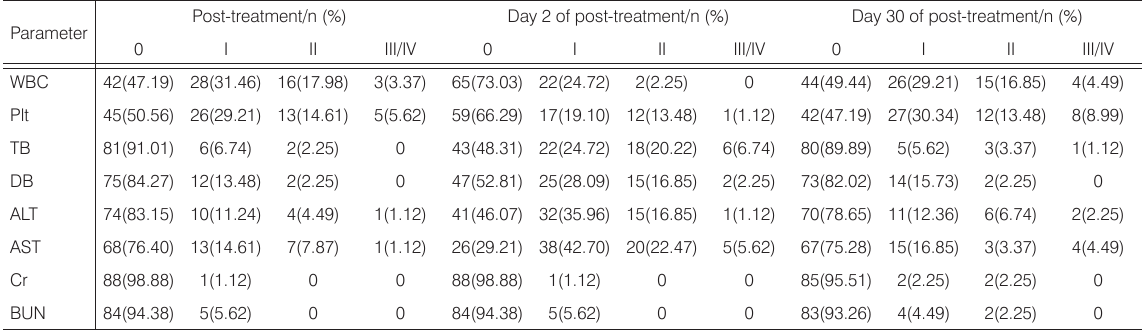
Table 2. WHO toxicity grading